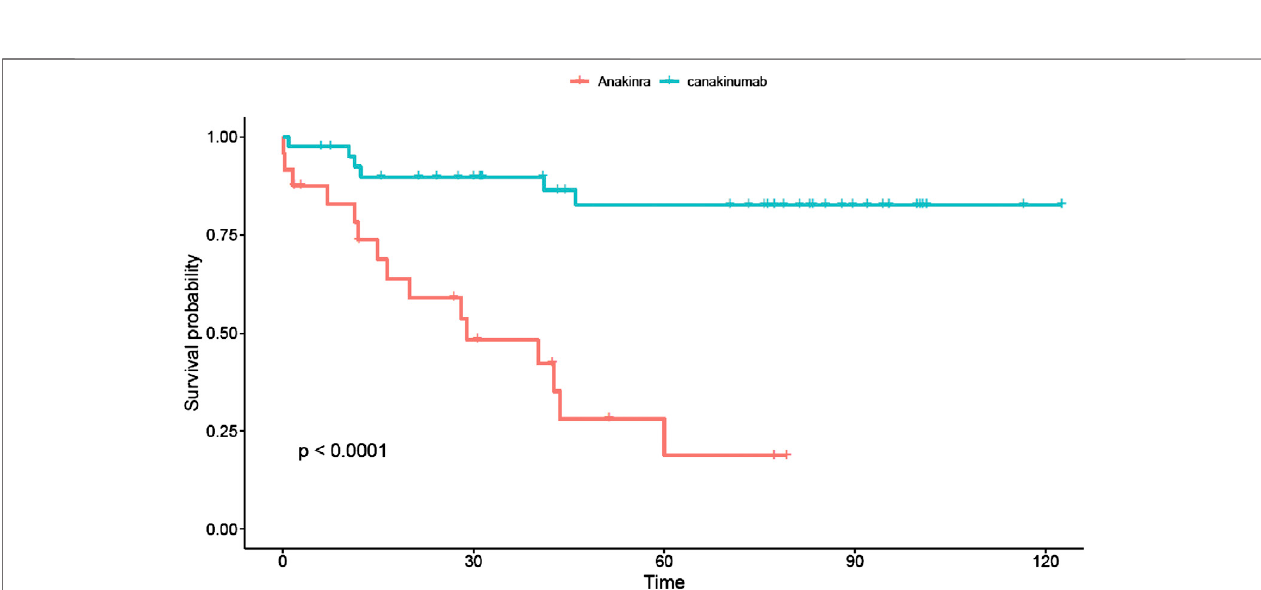
Frontiers in Pharmacology |